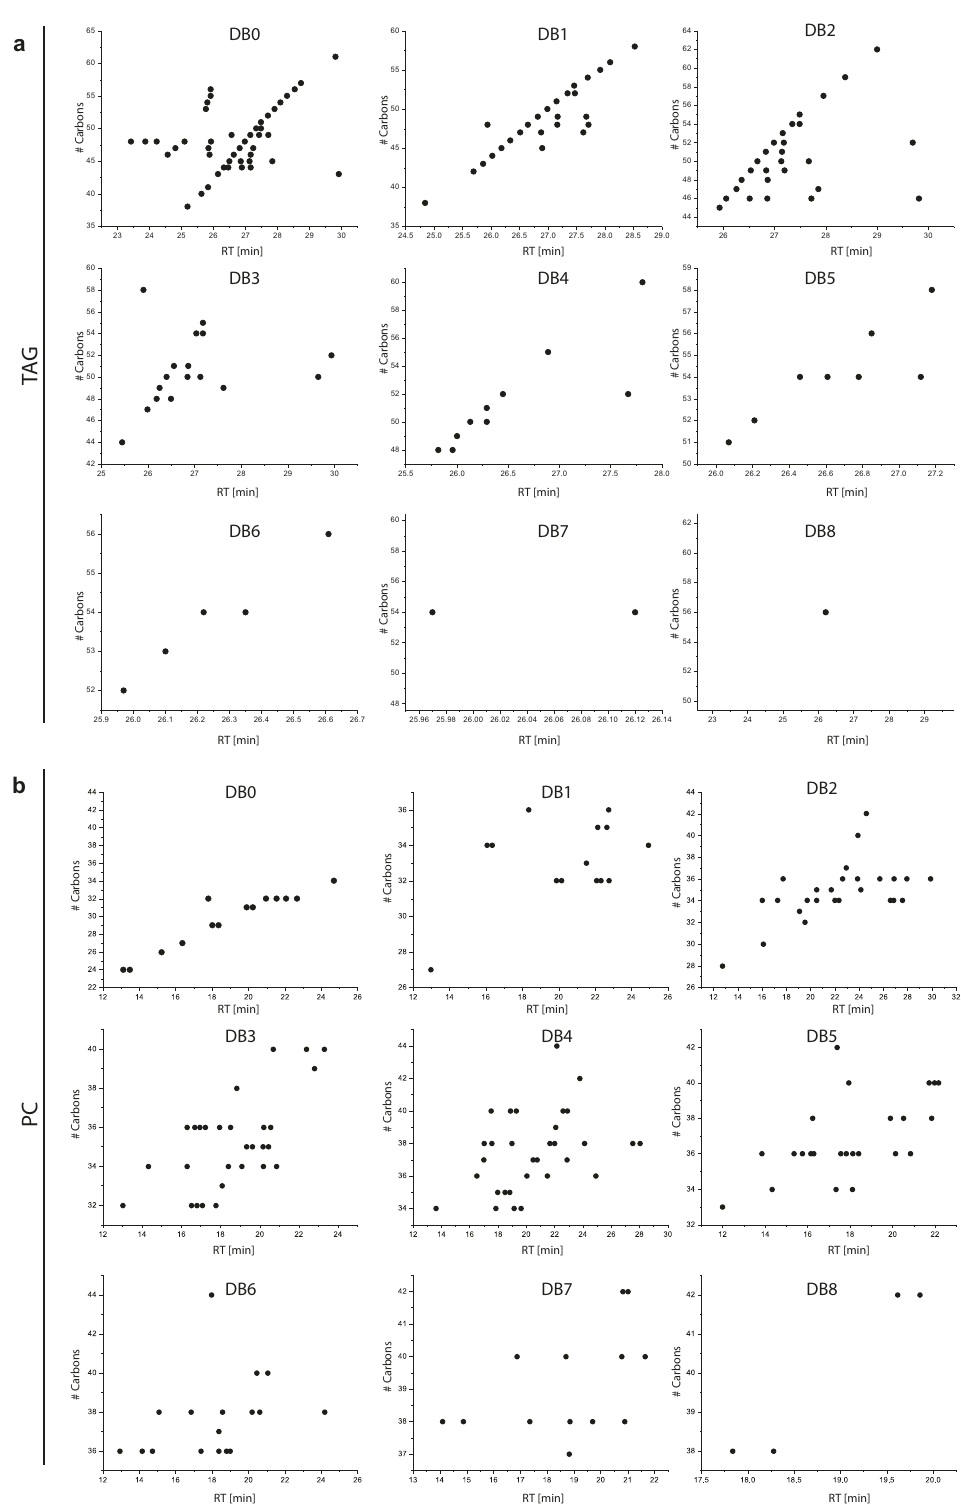
Fig. 1 Plot of retention times versus number of fatty acyl carbons. Shown are data for ( a ) triacylglycerols and ( b ) diacyl phosphatidylcholines in plasma. DB0 through DB8 represent the cumulative number of double bonds in the fatty acyl chains. For each individual DB assignment the relationship should be close to linear on a C18 stationary phase